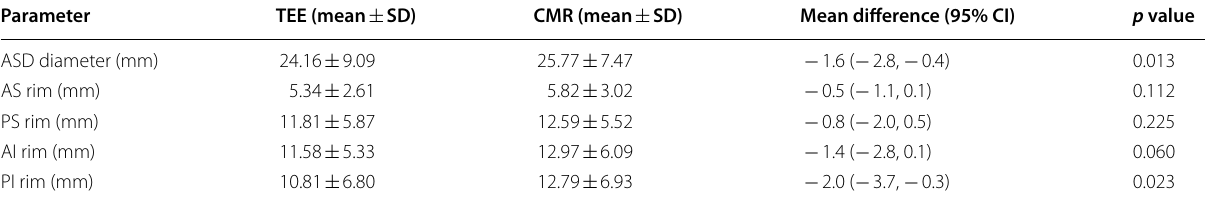
ASD atrial septal defect, TEE transoesophageal echocardiography, CMR cardiac magnetic resonance imaging, AS anterosuperior, PS posterosuperior, AI anteroinferior, PI